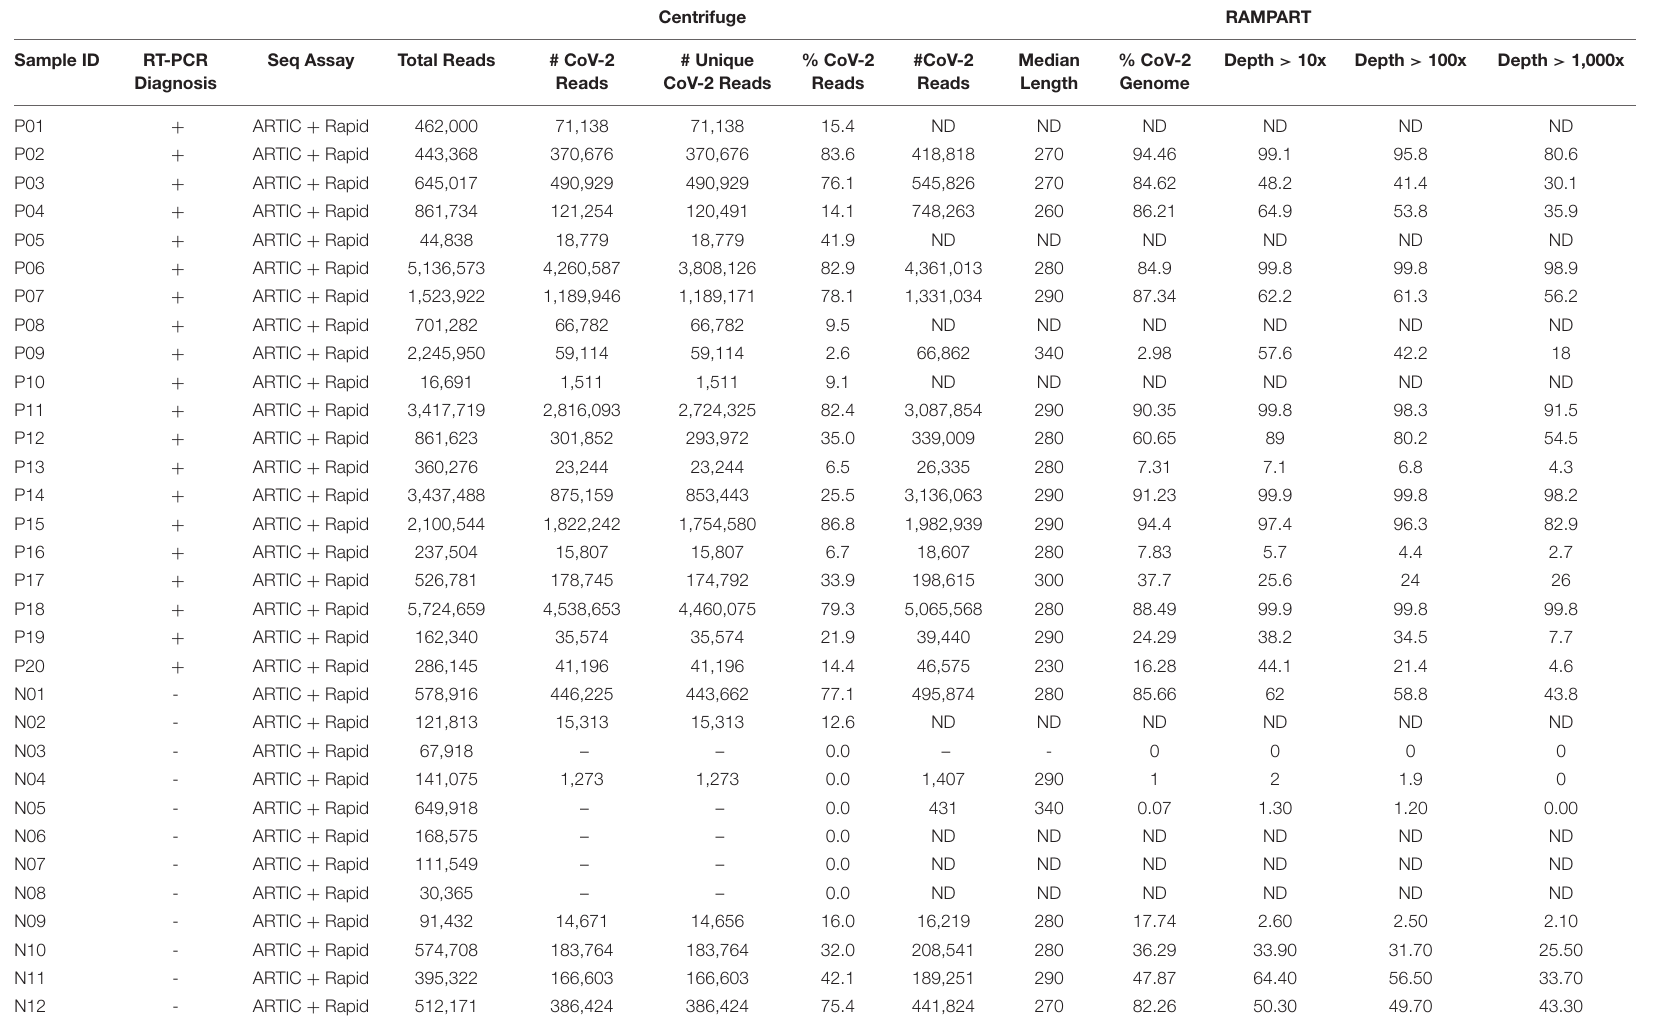
TABLE 4 | Sequencing of previously diagnosed clinical specimens by ARTIC with rapid sequencing